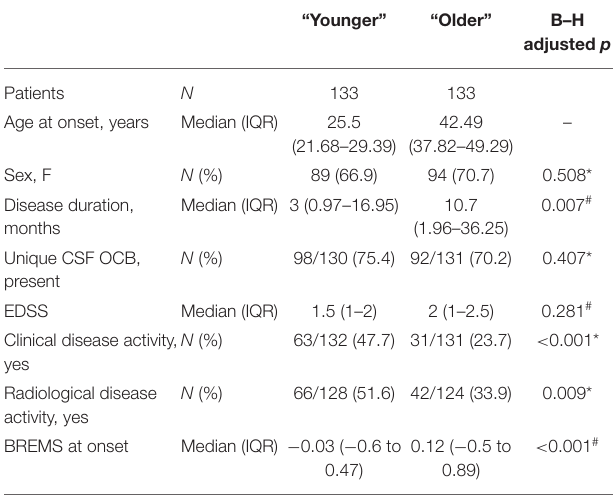
TABLE 2 | Clinical characteristics of patients with RR-MS according to the age group. controlling for multiple comparisons. To further exclude that different clinical and radiological “Younger” activity in the two age groups could affect CSF cytokine levels, we performed additional analyses by excluding patients with clinical or radiological activity at the time of CSF collection. When comparing patients with stable